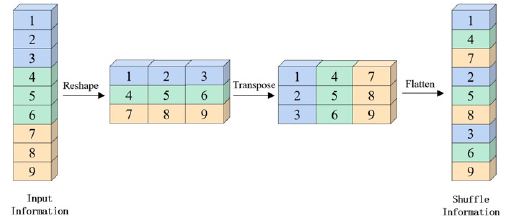
Figure 8. Semantic fusion module.